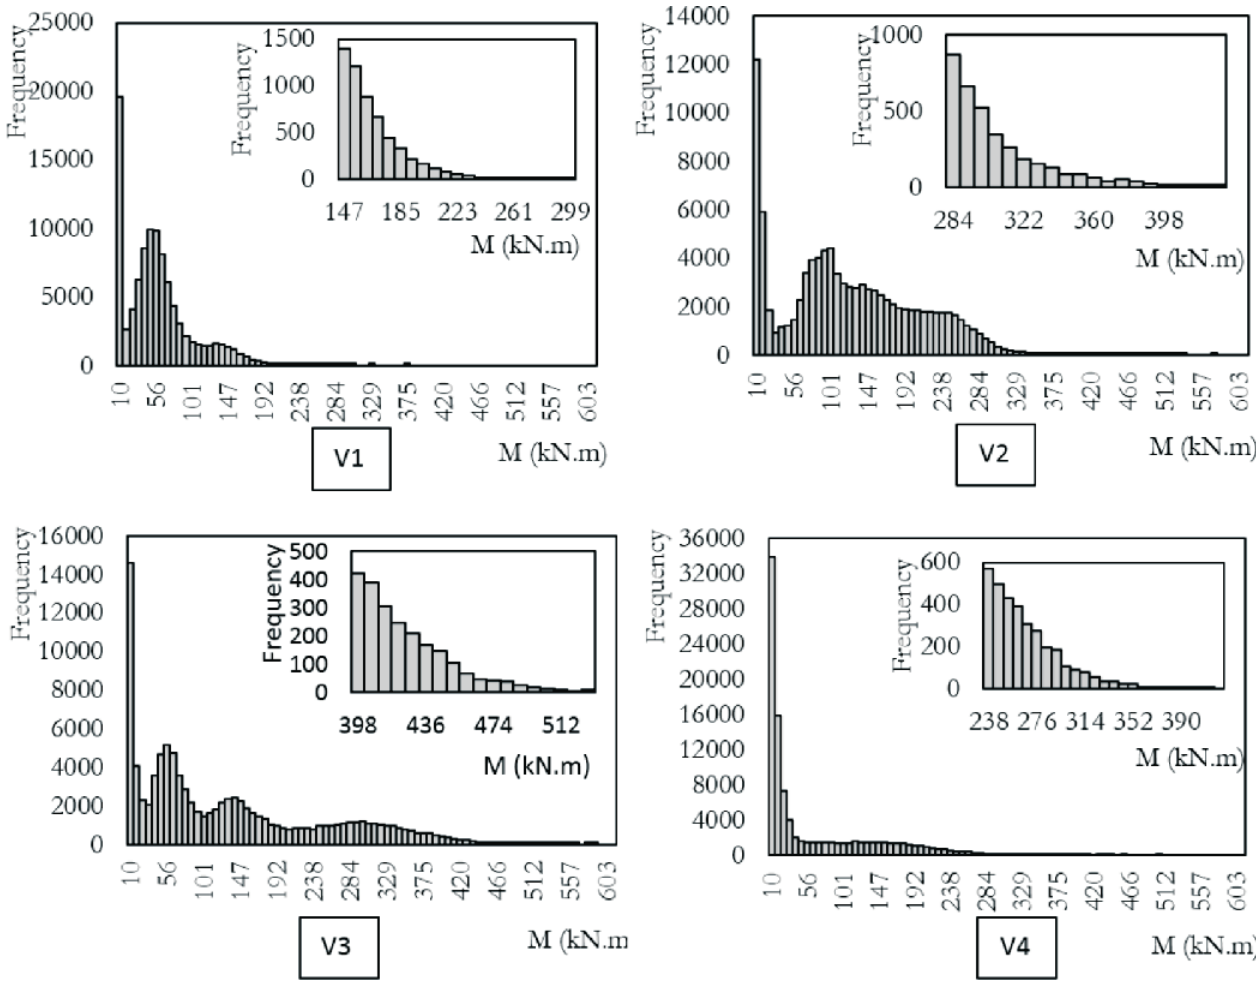
Bending moment histogram for each girder for the trucks passages during